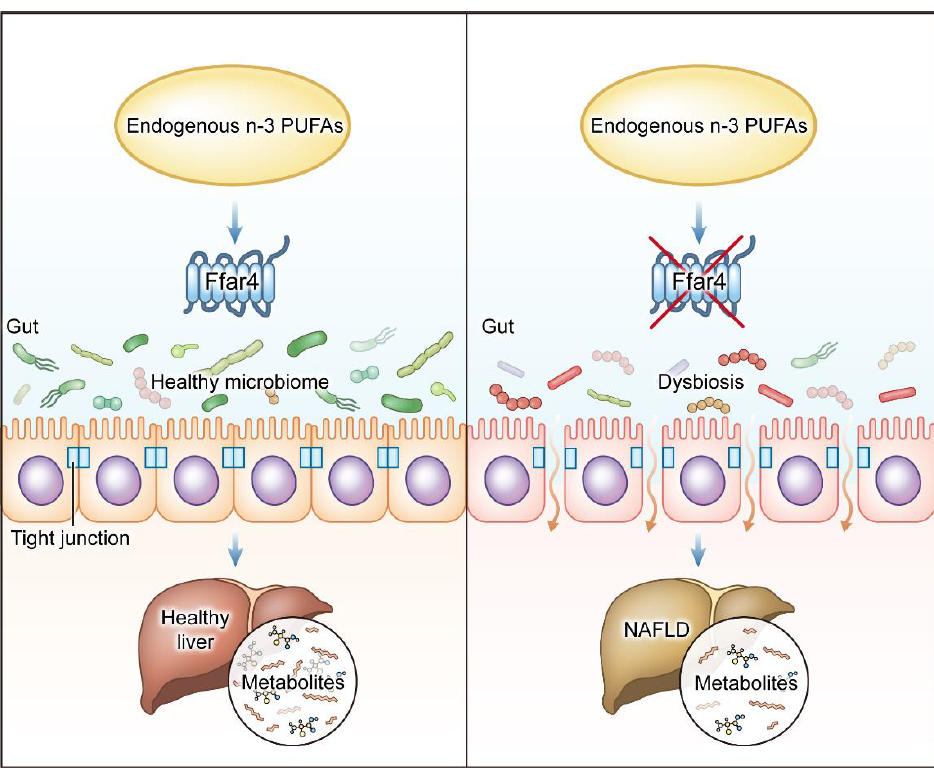
Figure 7. Endogenous n -3 PUFAs improved NAFLD through FFAR4-mediated gut – liver axis.